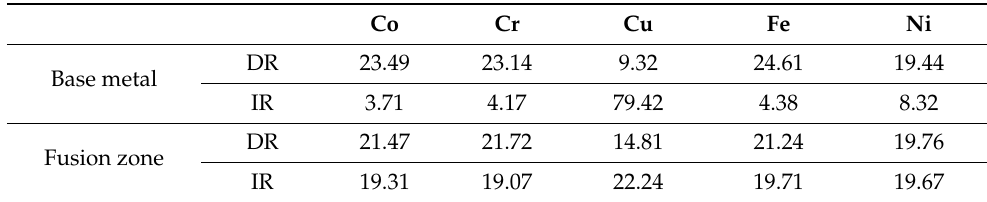
Figure 2. ( a ) OM and ( b ) SEM (backscattered electron) photograph of base metal. Table 1. Composition of base metal and fusion zone